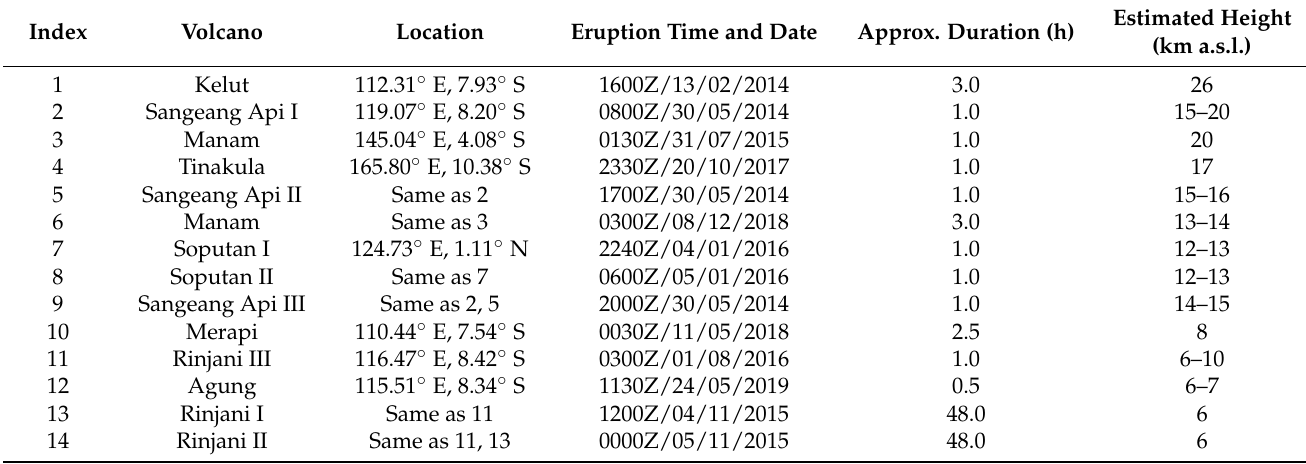
Figure 1. Map showing the locations of volcanoes used as case studies in this paper (black dots). Table 2. A brief description of the eruption case studies used in this paper. The eruption duration values are the ones used in the model. These are rough estimates based on inspection of satellite imagery. For cases studies prior to 2016, the frequency of satellite data was 1 h, so duration estimates shorter than this were not possible. For the Rinjani I and II case studies, the eruption was ongoing and, therefore, the eruption duration was set equal to the simulation